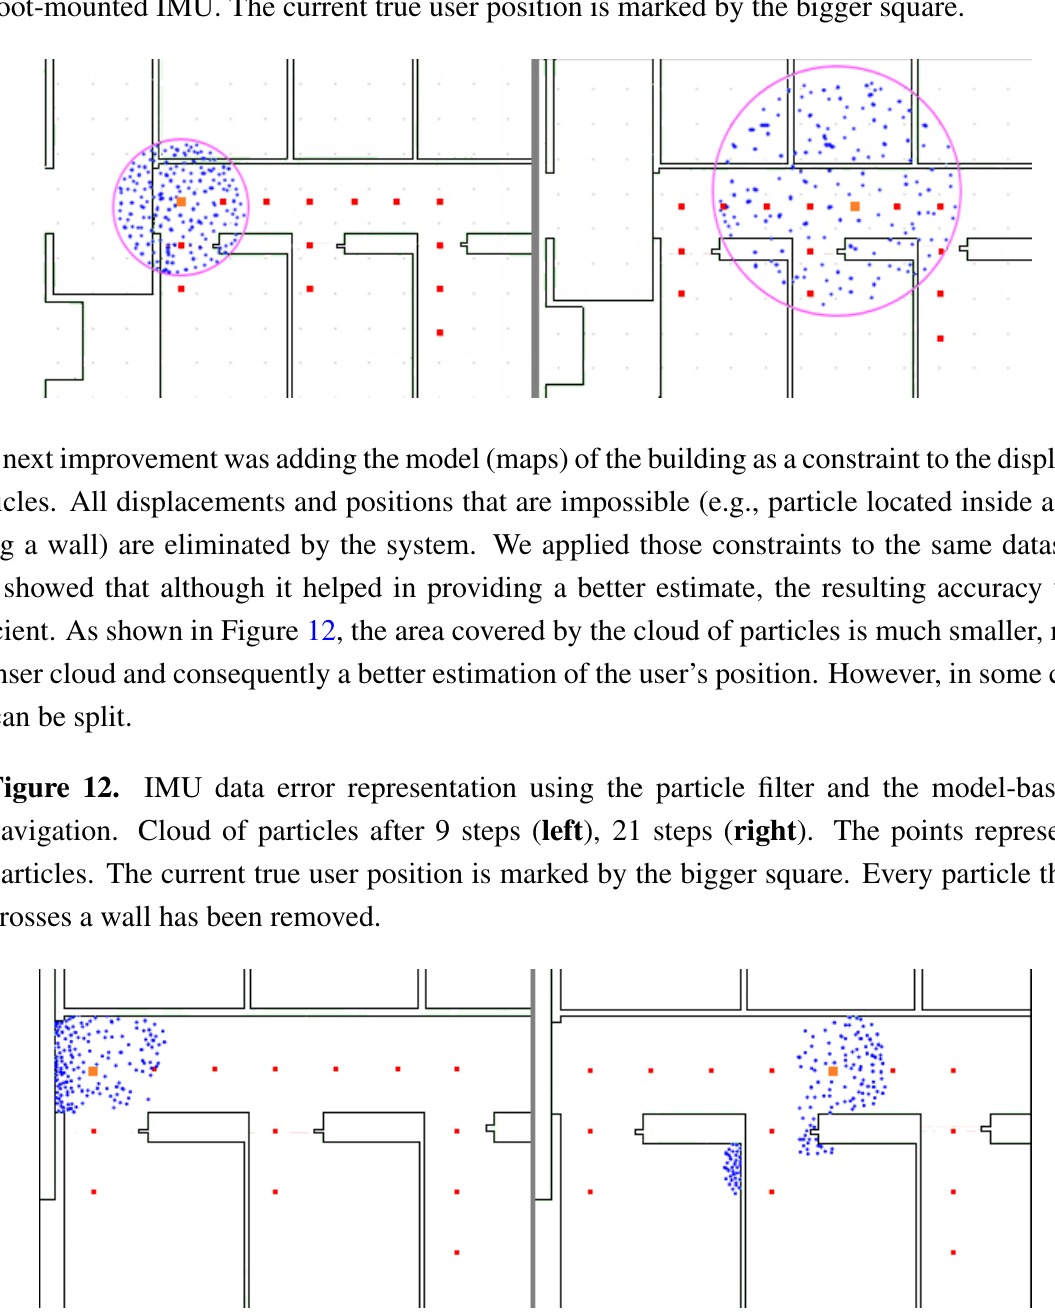
Figure 11. IMU data error representation using the particle filter. Cloud of particles after 9 steps ( left ), 21 steps ( right ). The points represent particles and the circles are the areas covered by the clouds. The circle is a representation of the estimated maximal error of the foot-mounted IMU. The current true user position is marked by the bigger square.